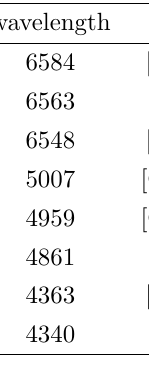
Table 2: Emission lines in V2282